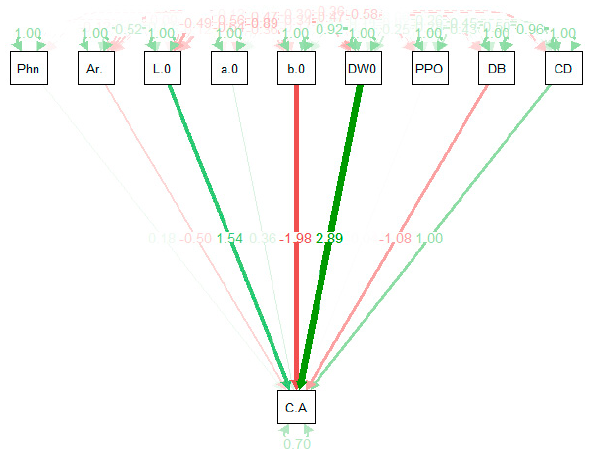
Figure 2. Path coefficient analysis considering chlorogenic acid content as the dependent variable on all other remaining traits.